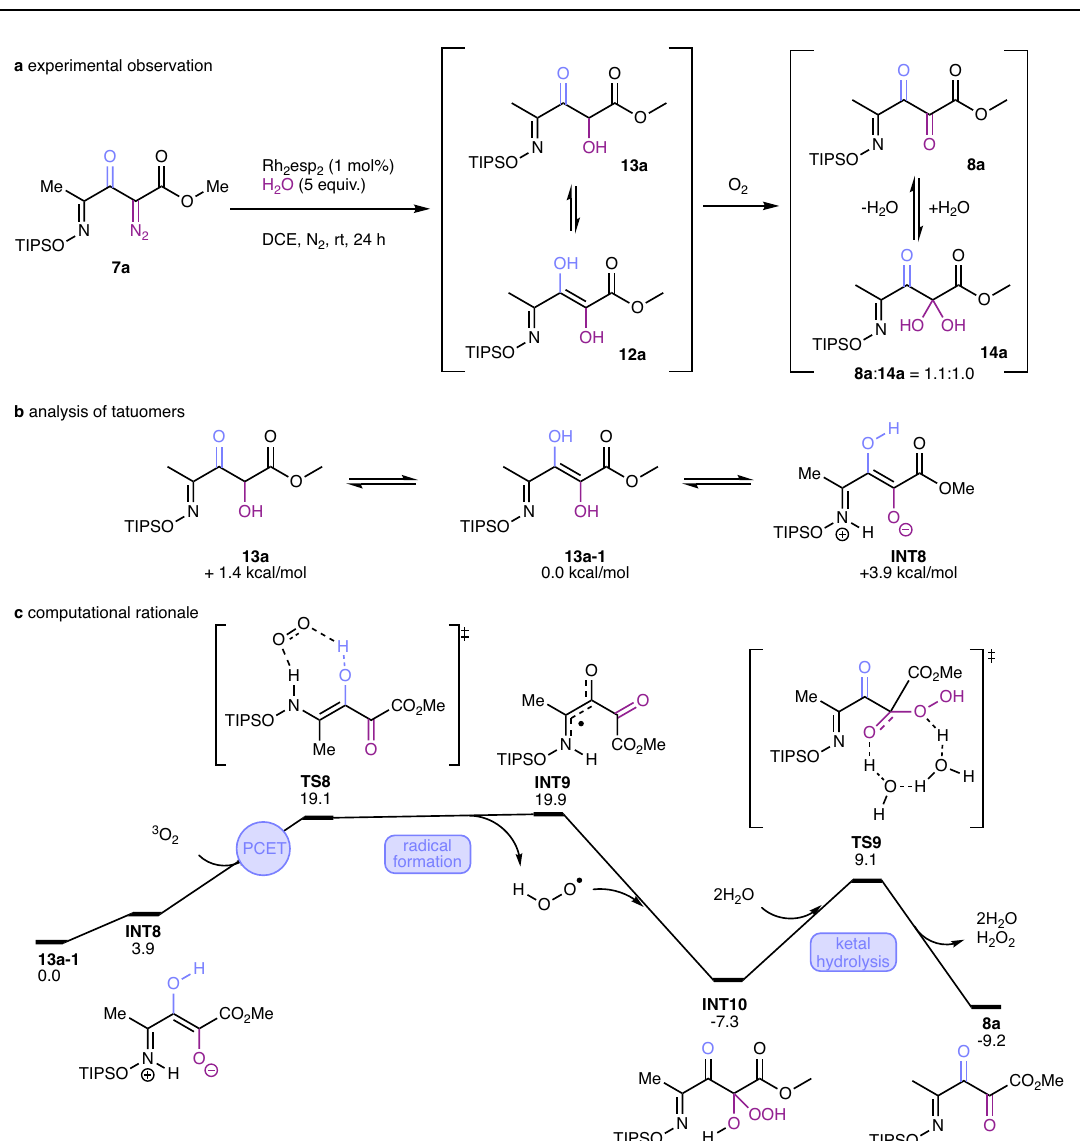
Fig. 4 | Carbene transfer reaction of oxime 10c. Rhodium-catalyzed reaction of unprotected oxime with acetone and X-ray crystal structure.